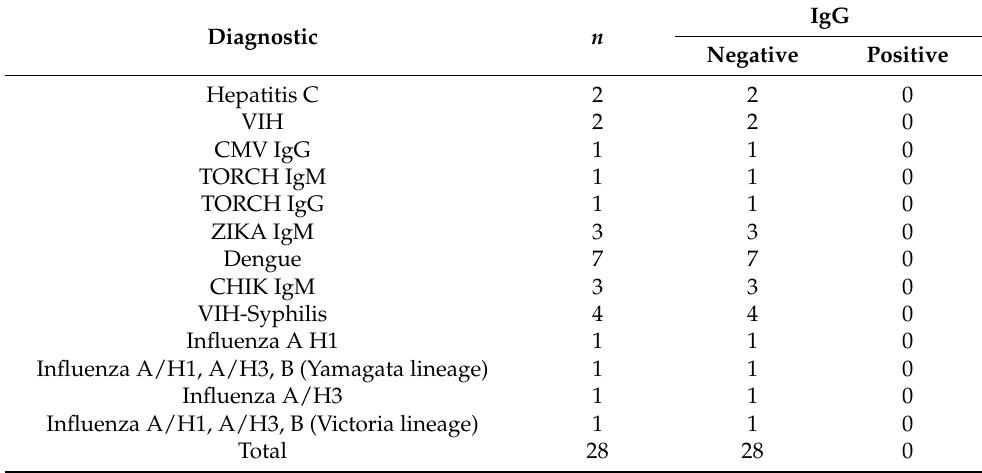
Table 2. The analytical specificity of UDITEST-V2G ®